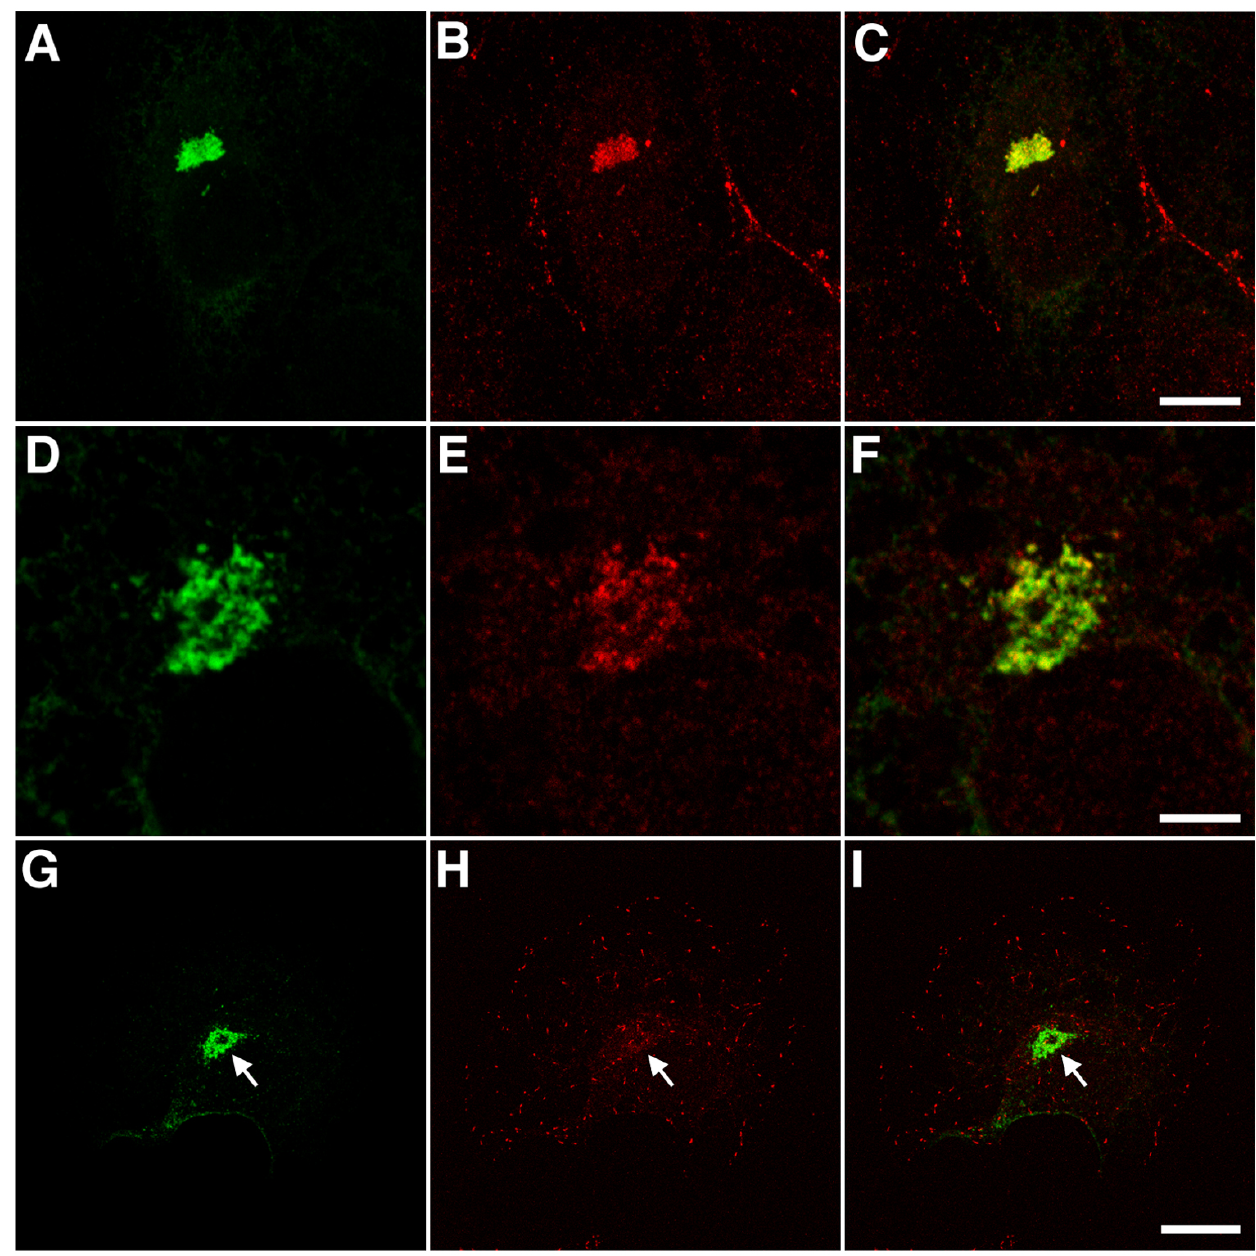
Figure 6 APC is present in EB1- ∆ N2-GFP aggresomes. Panels A-C. Cells expressing EB1- ∆ N2-GFP were fixed and co-immunostained for GFP (green, panel A) and APC (red, panel B). A merged image is shown in panel C. APC is seen in aggresomes in trans- fected cells and at peripheral sites in adjacent untransfected cells. Bar = 10 µ m. Panels D-F. A single 0.365 µ m confocal section through a cell expressing EB1- ∆ N2-GFP. APC immunoreactivity (panel E) in aggresomes is heterogeneous but only seen in association with GFP immunoreactivity (panels D and F). Bar = 5 µ m. Panels G-I. Cells expressing EB1- ∆ N2-GFP were fixed and co-immunostained for GFP (green, panel G) and EB3 (red, panel H). EB3 is seen at microtubule tips but is not present in EB1- ∆ N2-GFP aggresomes. Bar = 20 µ m. Images in panels A-C and G-I are projections of confocal image